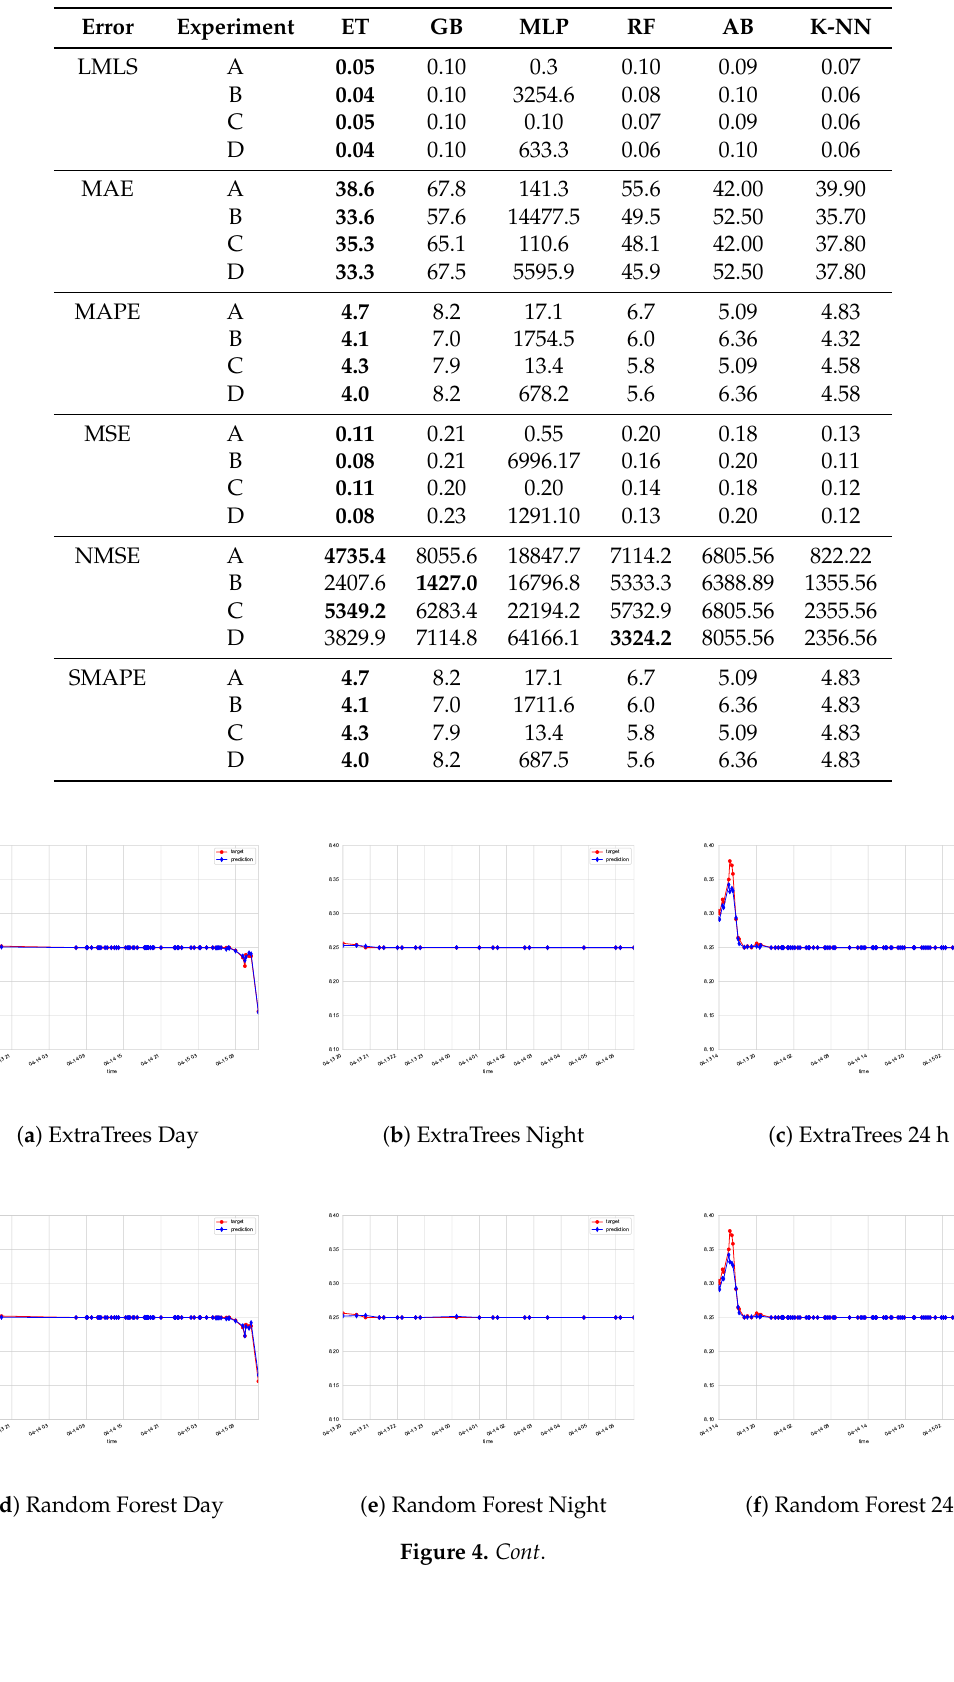
Table 3. Night model errors (multiplied by 10 5 ) for extremely randomized trees (ET), gradient boosting (GB), multi-layer perceptron (MLP), random forest (RF), adaptive boosting (AB), and k-nearest neighbors (K-NN).